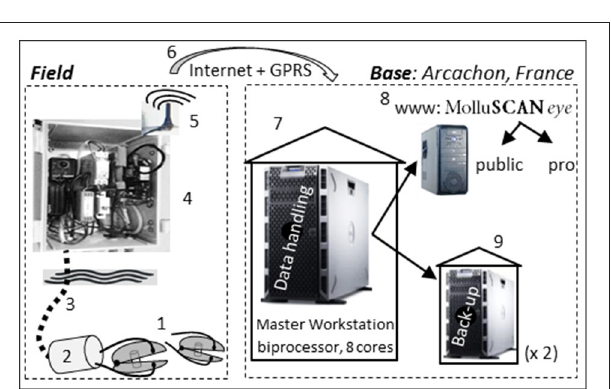
FIGURE 2 | Synoptic representation of a MolluSCAN eye system, from field to laboratory. (1) Clams equipped with a couple of electrodes, (2) 1st level electronic card in a waterproof box close to the clams; (3) electrical connection between the first and the second electronic cards (umbilical); (4) 2nd level electronic card out of water; (5) GPRS antennae (6) GPRS and Internet connection; (7) Marine Station of Arcachon (Master unit) ready for daily update and for feeding internet (Google: molluscan eye); (8) daily update on internet for the general public (restricted access) and professionals (full access), (9) two back-up located in two geographically distinct places. Basically, the system architecture is composed of robust slave-modules in the field (1–5; energy consumption, 1 watt) and a single powerful master workstation (7) in Arcachon, France, to handle megabytes of daily